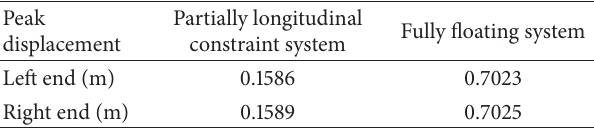
Table 1: Peak displacements at two ends of the bridge